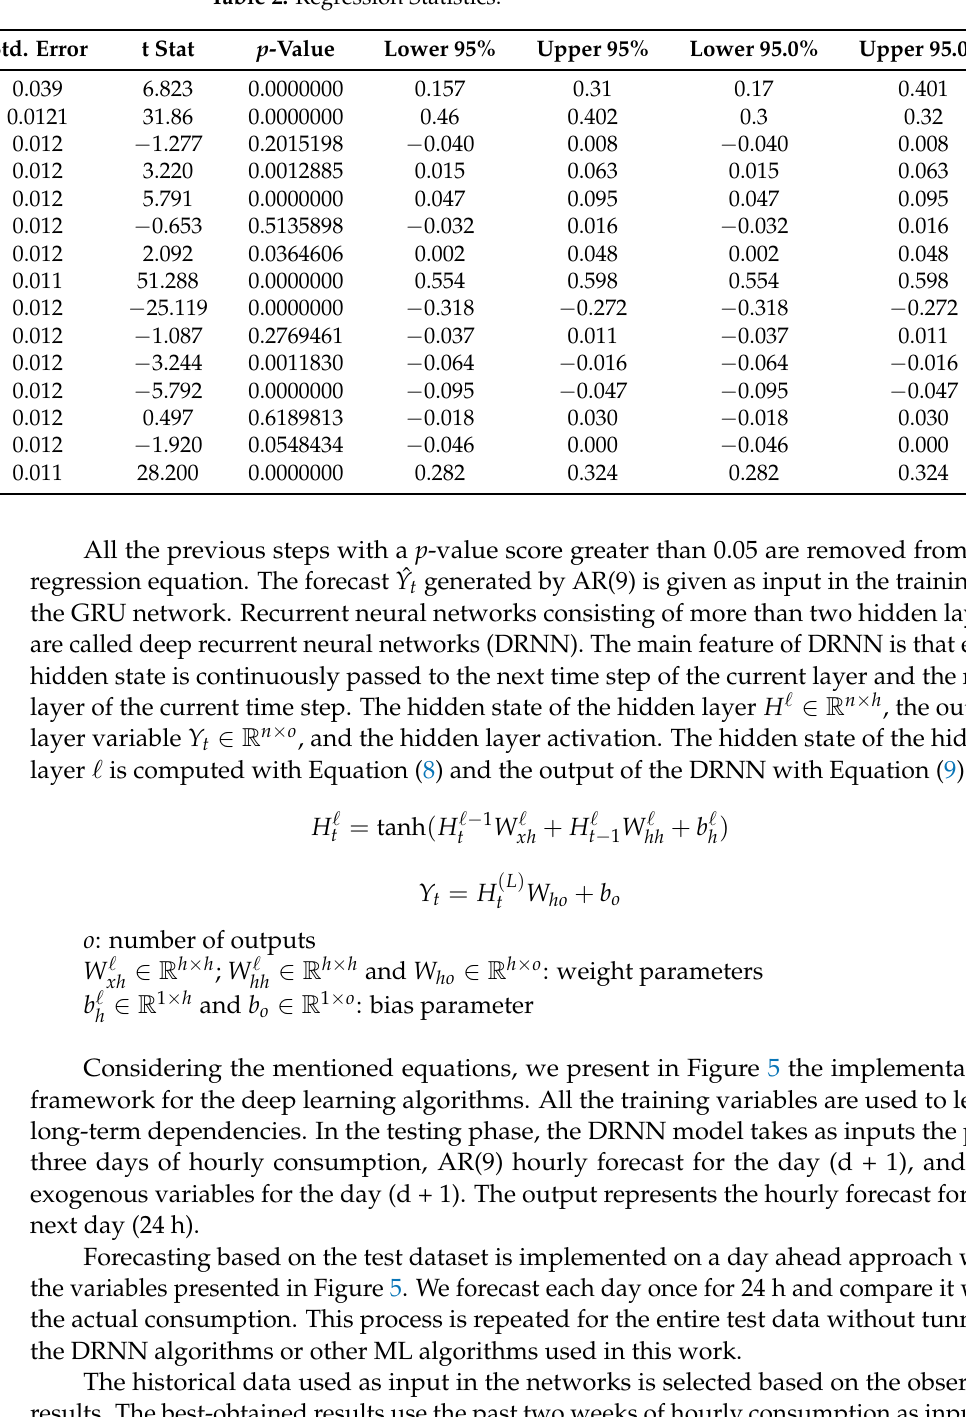
Table 2. Regression